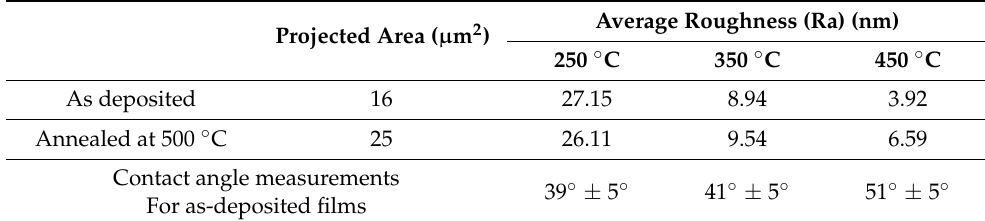
Figure 2. Three-dimensional AFM images of the as-deposited and annealed films. Table 1. Roughness and contact angle for the deposited and annealed samples.